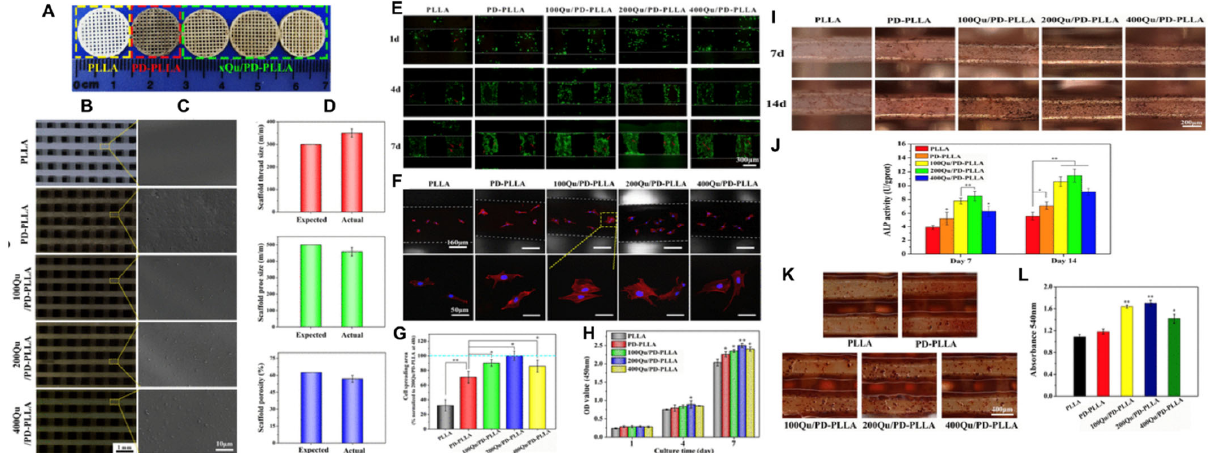
Figure 13. Three ‐ dimensional printed scaffolds of PLLA, PD ‐ PLLA, and Qu/PD ‐ PLLA with their stereomicroscope images. ( A ) Camera images, ( B ) stereomicroscope images, and ( C ) SEM images of the 3D ‐ printed scaffolds of PLLA, PD ‐ PLLA, 100Qu/PD ‐ PLLA, 200Qu/PD ‐ PLLA, and 400Qu/PD ‐ PLLA. ( D ) Printing reproducibility and accuracy were studied by quantification of thread diameter, pore size, and porosity determined by image analysis from stereomicroscope pictures. ( E ) Live/dead fluorescent staining images of MC3T3 ‐ E1 cells on the PLLA, PD ‐ PLLA, and Qu/PD ‐ PLLA scaffolds after 1, 4, and 7 days of culture. The confocal laser scanning microscopy images of ( F ) morphology and ( G ) quantification of spreading area of the MC3T3 ‐ E1 cells after culturing on the PLLA, PD ‐ PLLA, and Qu/PD ‐ PLLA scaffolds for 48 h. The OD value of the MC3T3 ‐ E1 cells culturing on the PLLA, PD ‐ PLLA, and Qu/PD ‐ PLLA scaffolds for ( H ) 1, 4, and 7 days. ( I ) ALP staining, and ( J ) ALP activity of MC3T3 ‐ E1 cells after culturing on the PLLA, PD ‐ PLLA, and Qu/PD ‐ PLLA scaffolds for 7 and 14 days. ( K ) Alizarin red staining and ( L ) quantitative result of MC3T3 ‐ E1 cells after culturing on the PLLA, PD ‐ PLLA, and Qu/PD ‐ PLLA scaffolds for 21days. Reprinted with permission from Ref. [185], Copyright 2019, Taylor & Francis.